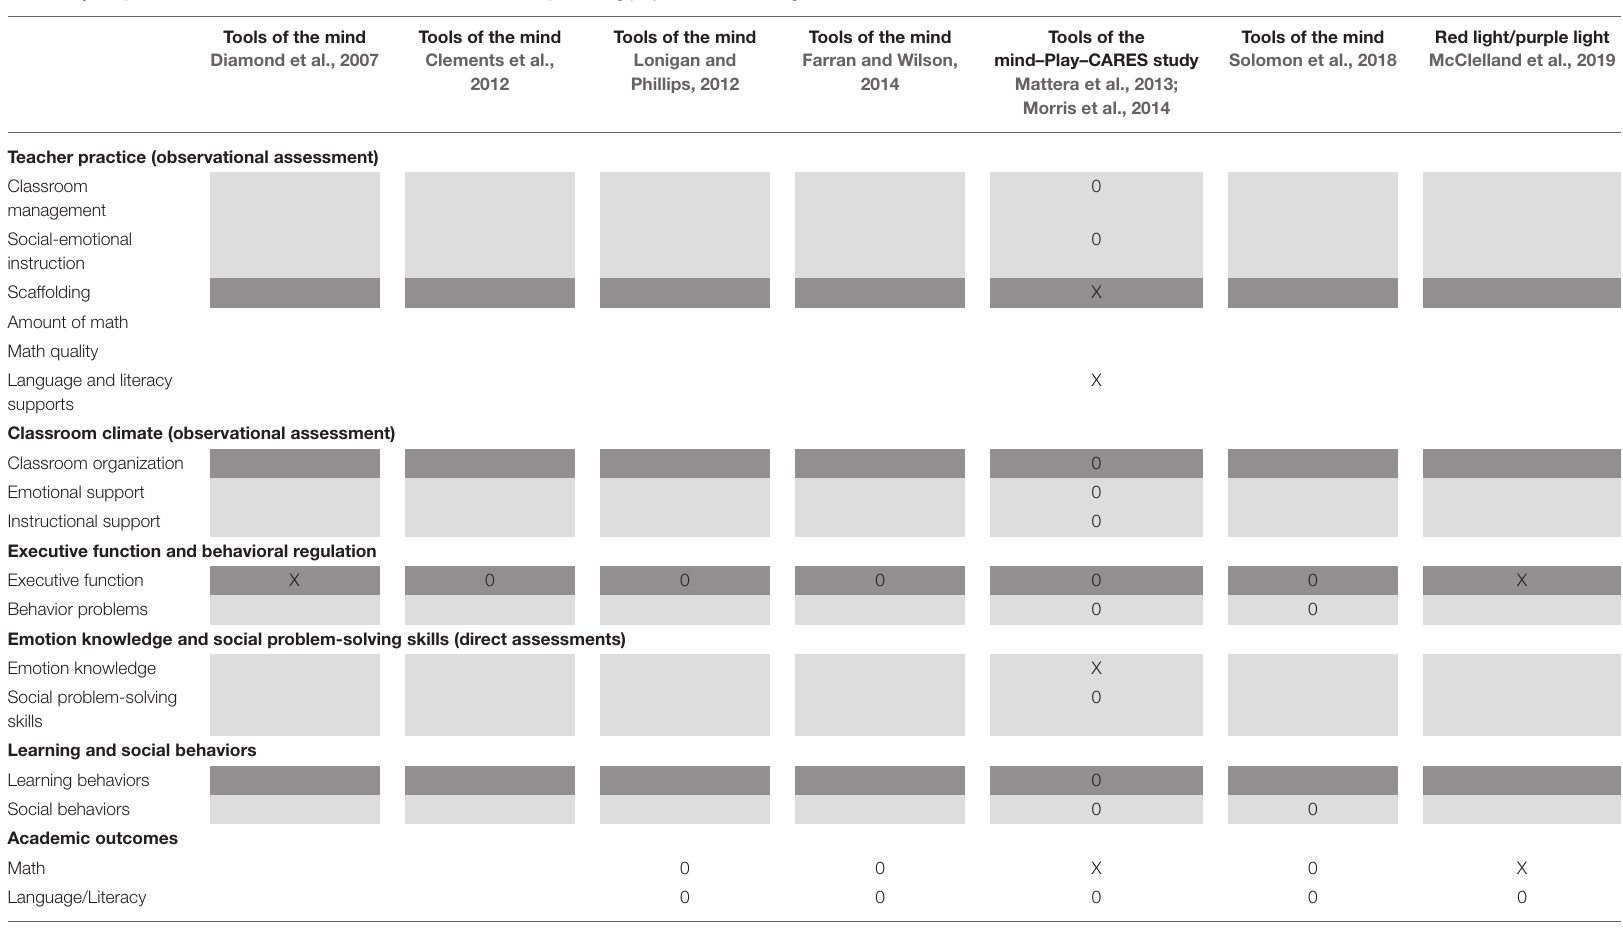
TABLE 7 | The pattern of effects on teacher and child outcomes across promoting play and direct training interventions.